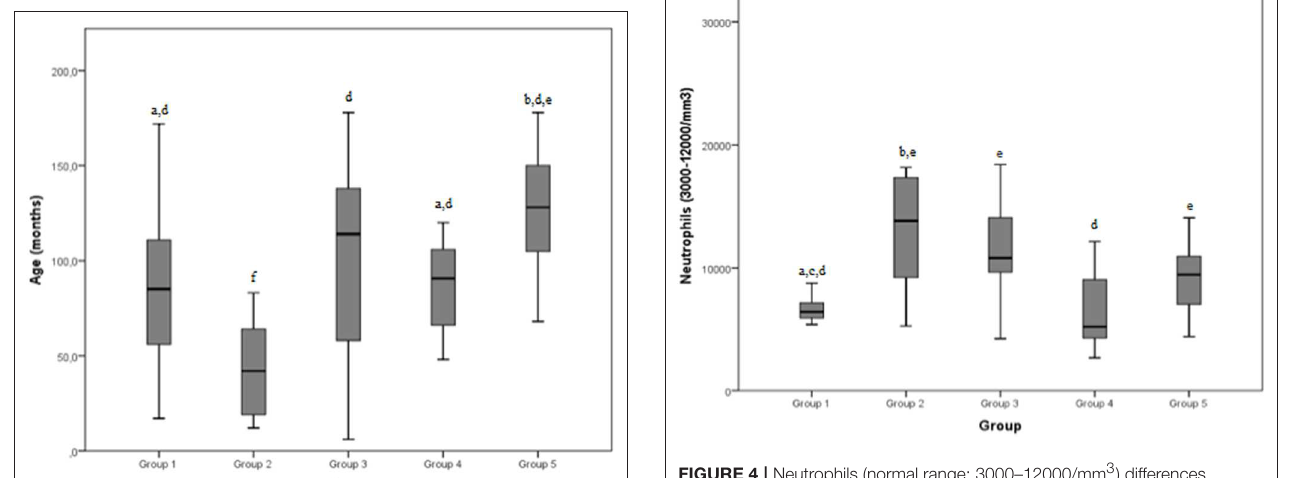
FIGURE 4 | Neutrophils (normal range: 3000–12000/mm 3 ) differences between the five examined groups. Statistically significant differences are indicated as follows: (a) significantly different from group 5; (b) significantly different from group 4; (c) significantly different from group 3; (d) significantly different from group 2; (e) significantly different from group 1.